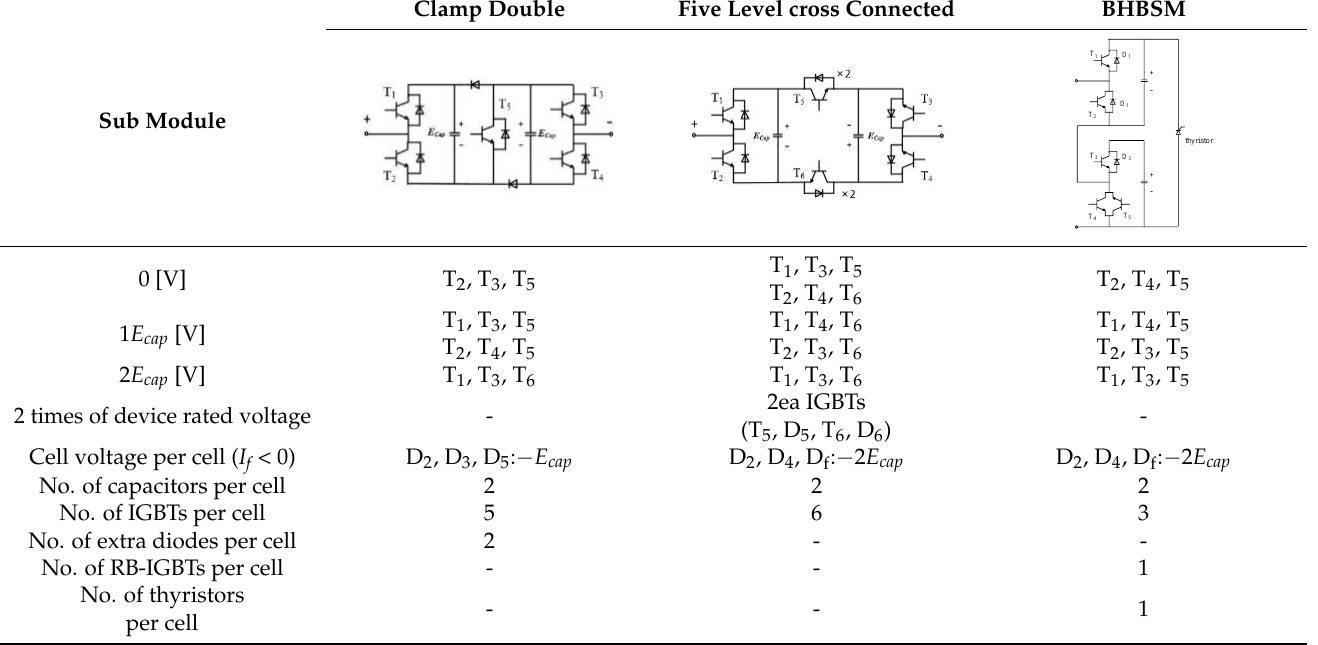
Table A2. Comparison between conventional sub-module topologies with FRT capability (three-level cell).